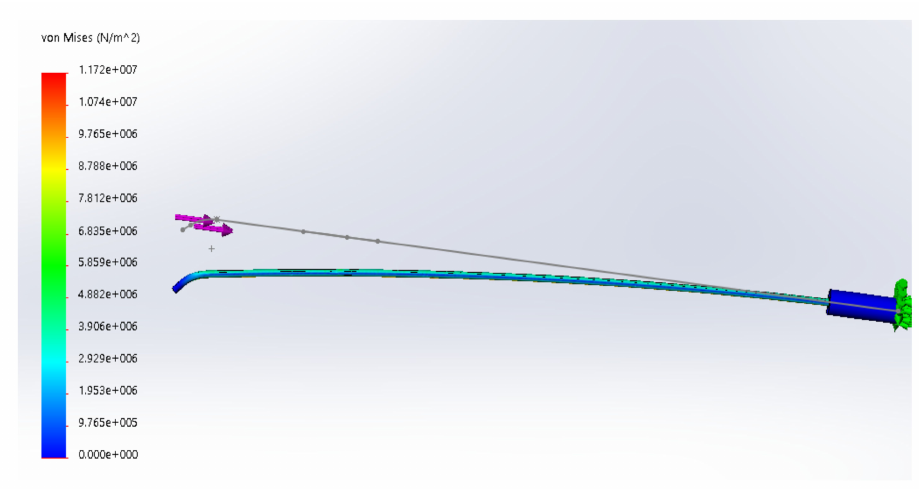
in blue and large deformation in red. The results show that the force on the head of the catheter has an effect on the deformation of the posterior catheter, and the bending direction is the same as that in the front. The length of the catheter is 80 cm. According to the simulation results, 10 cm from the tail of the catheter is selected as the stress analysis point. The deformation here and the deformation of the catheter head are analyzed to further find the corresponding relationship between them.